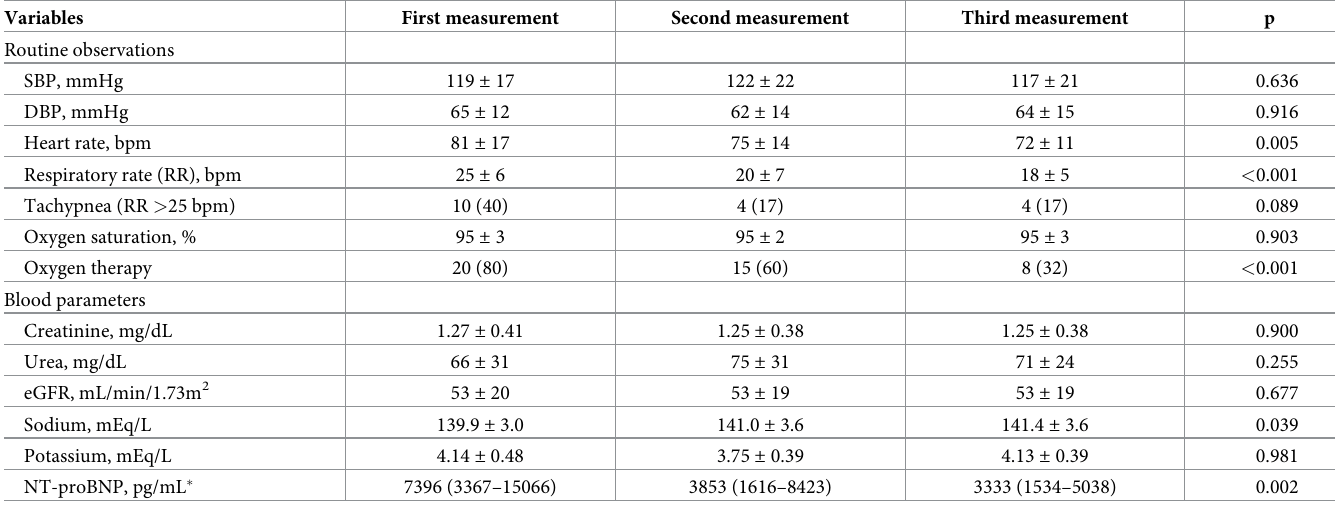
Table 2. Changes in clinical and analytical parameters along